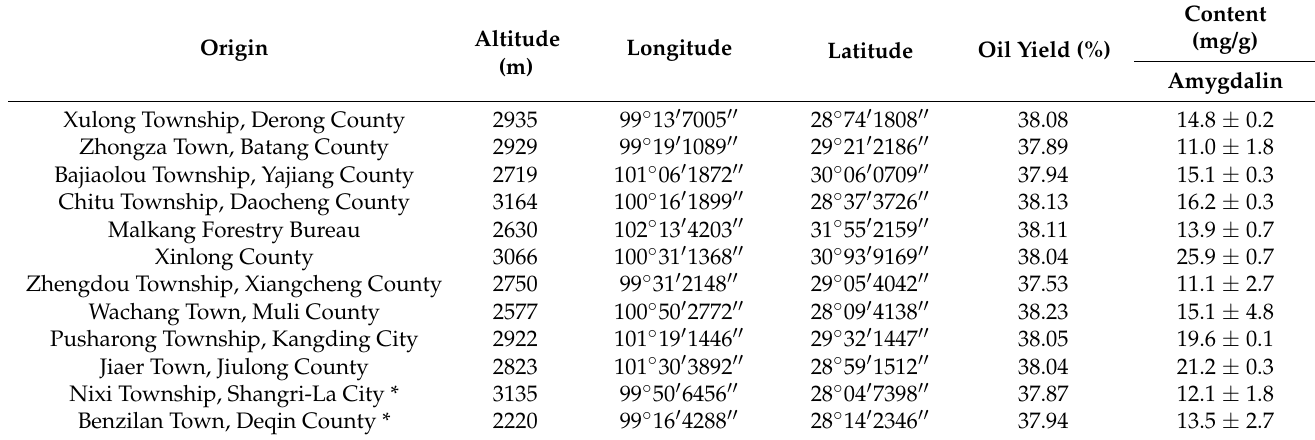
Table 12. Contents of amygdalin in the kernels of P. mira